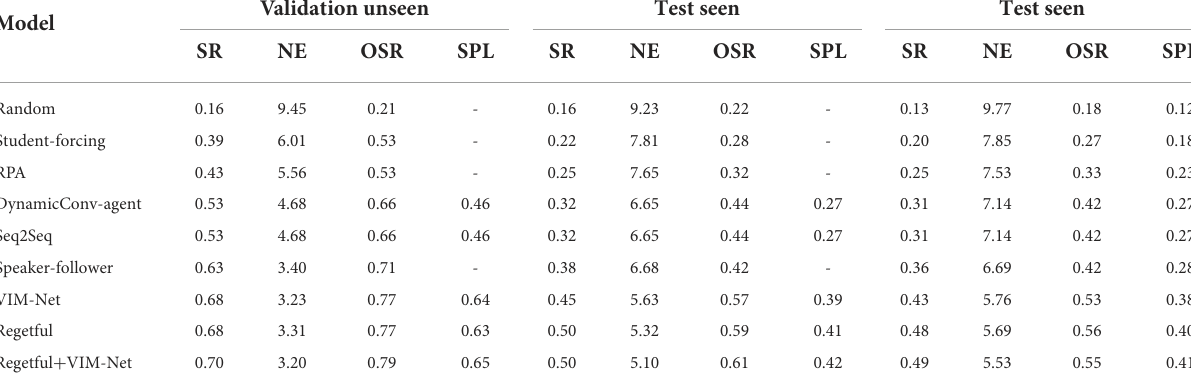
TABLE 5 The display table of results from other models.